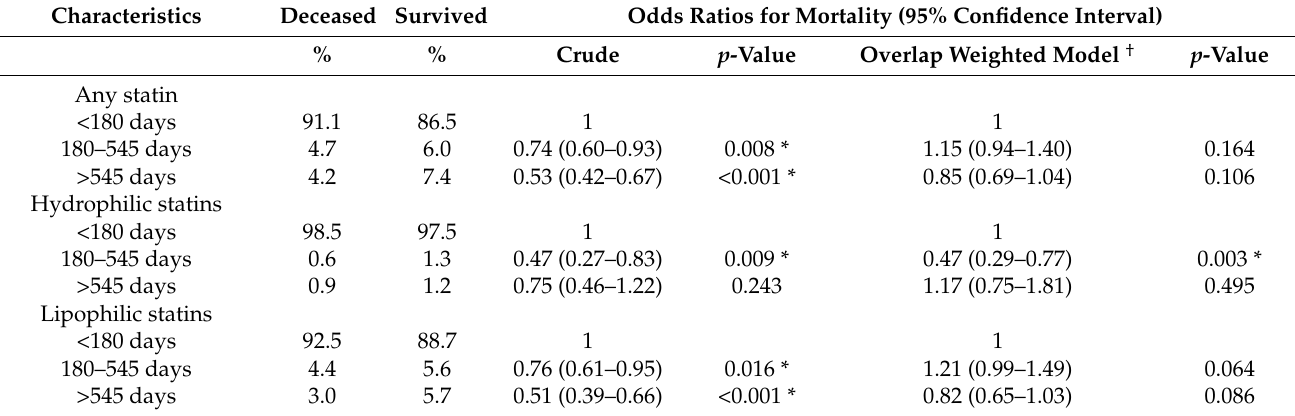
Figure 3. Forest plots for multivariable conditional logistic regression depicting the overlap weighted odds ratios (95% confidence intervals) of previous use duration of lipophilic statins for incident gastric cancer according to comprehensive subgroup analyses, including age, sex, income, region of residence, obesity, and smoking ( a ), alcohol consumption, systolic blood pressure, diastolic blood pressure, fasting blood glucose, total cholesterol, CCI scores, and dyslipidemia history ( b ). The reference period is <180 days. Full results of the crude and adjusted overall weighted models are available in Supplementary Table S3 (lipophilic statins). Table 4. Crude and overlap propensity score weighted odds ratios of dates of statin prescriptions for overall mortality in gastric cancer